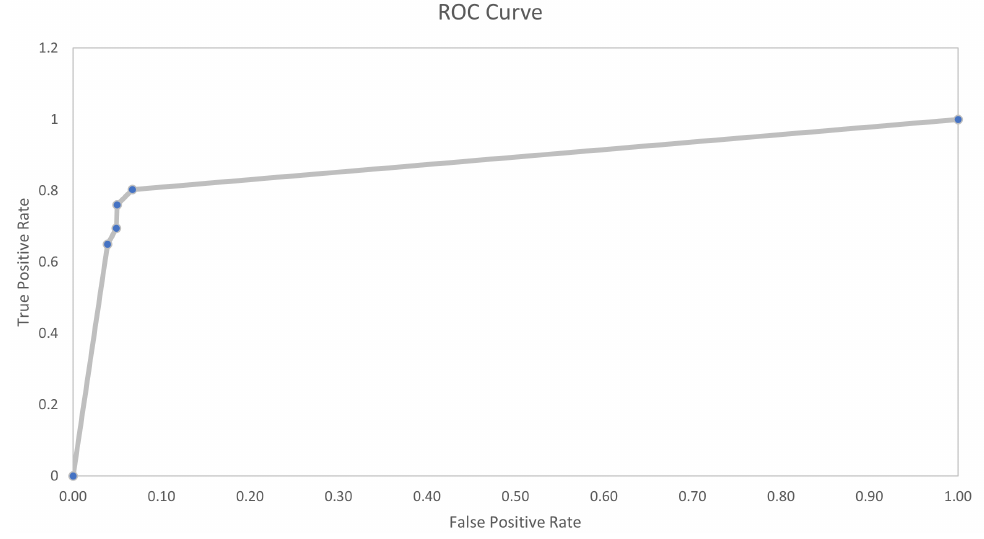
Figure 17. Decision tree ROC curve. Table 8. Performance